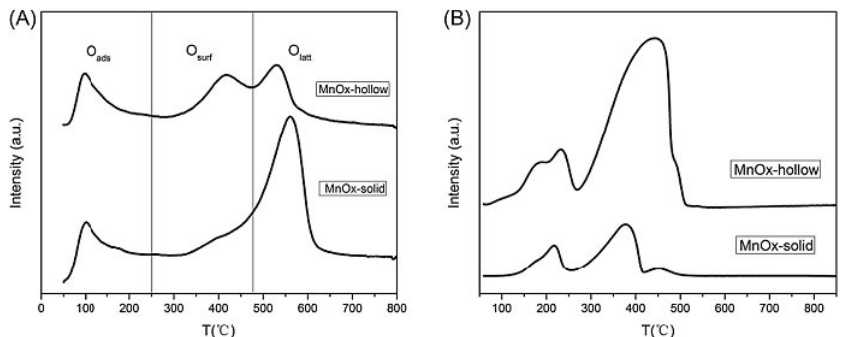
Figure 16. ( A ) O 2 ‐ TPD and ( B ) H 2 ‐ TPR profiles of MnOx ‐ hollow and MnOx ‐ solid. Reprinted with permission from Ref. [102]. Copyright 2017 Elsevier.